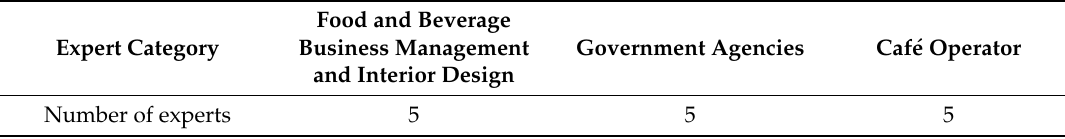
Table 1. Proportions of experts from di ff erent